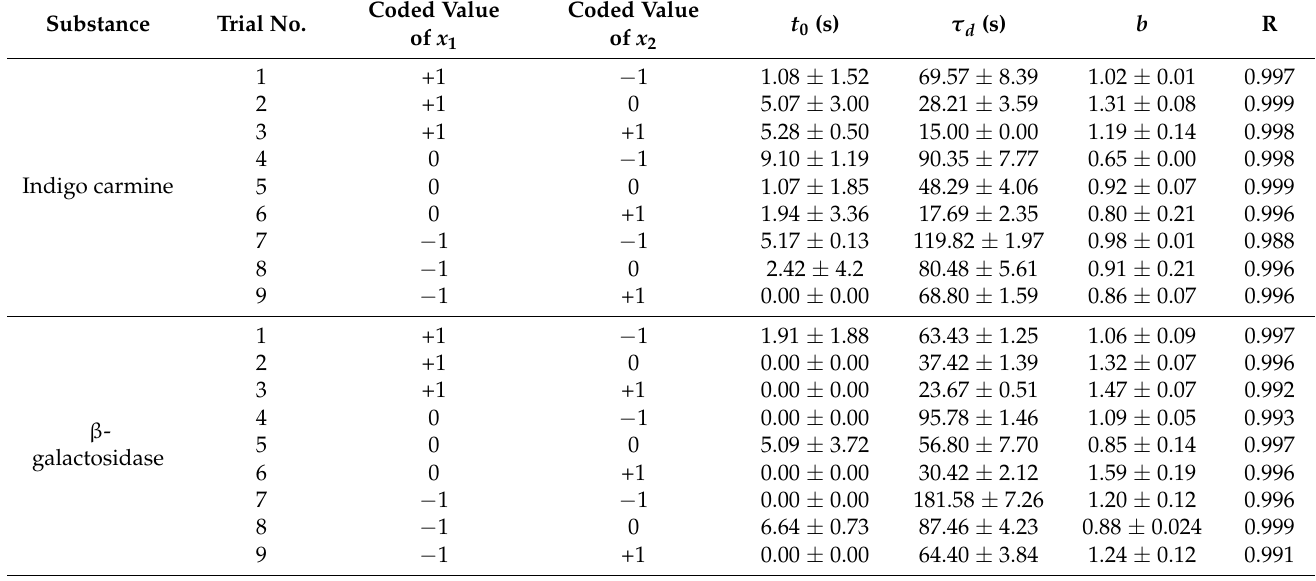
Table 5. Symbolised levels of independent variables of the experimental design and kinetic parame- ters of dissolution estimated according to the Weibull distribution function (Mean ±